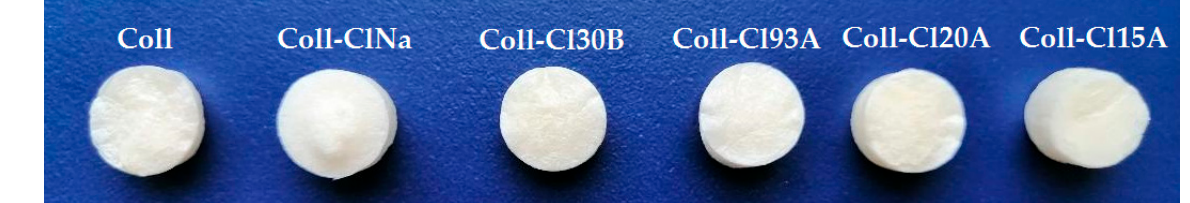
Figure 12. Obtained collagen/clay composite biomaterials (without gentamicin). The freeze-dried composite scaffolds were evaluated by Fourier-transform infrared spectroscopy, X-ray diffraction, scanning electron microscopy, differential scanning calorime- try, thermo gravimetric analysis, swelling ratio, biodegradation ratio, mechanical tests, drug release, antimicrobial tests, and cellular